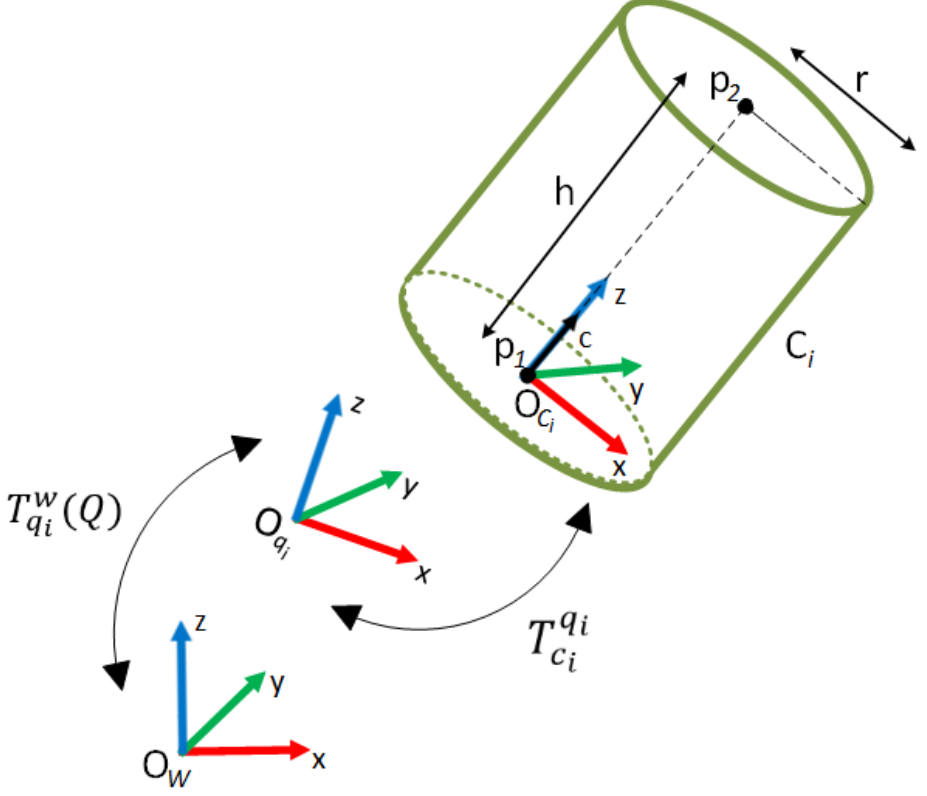
Figure 5. The geometry of the cylinder and its parameters.